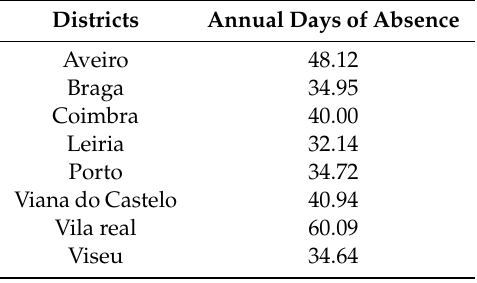
Table A2. Annual days of absence due to non-fatal work-related